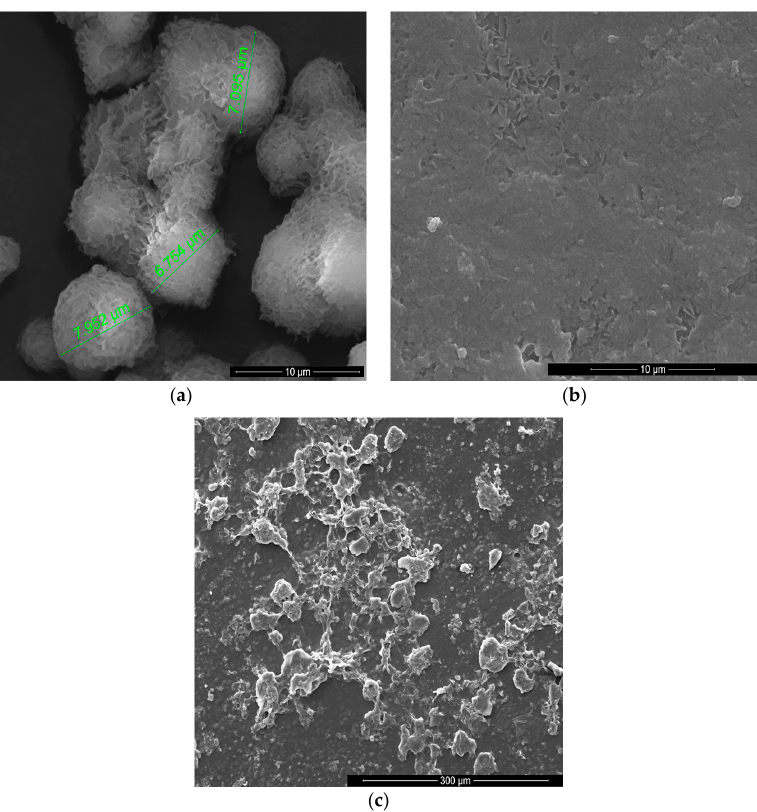
Figure 4. SEM images of the GPCa modifier ( a ) and the surface of PUR ( b ) and PUR-M ( c ).